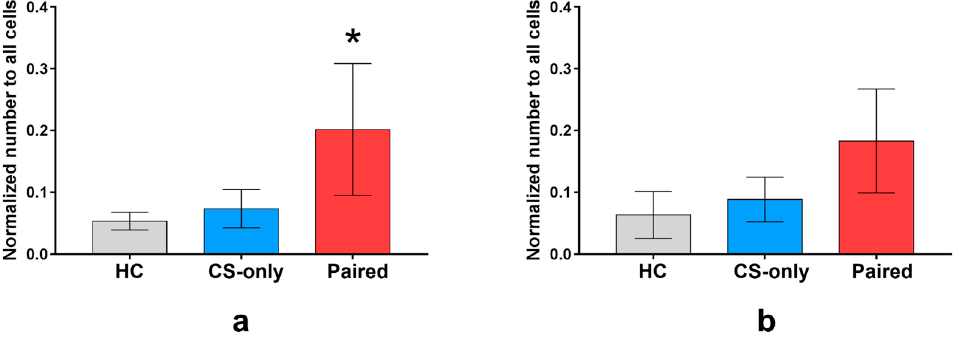
Figure 4. Number of the PtA neurons that were inactive before FC and active during ( a ) fear learning and ( b ) memory retrieval on the next day normalized to all identified neurons in Fos-EGFP mice (mean, 95% CI). The number of neurons that were inactive before FC and were active during FC was higher in the Paired group ( n = 7) than in CS-only ( n = 6) and HC ( n = 3) groups (* p < 0.05, one-way ANOVA and post hoc Tukey test).